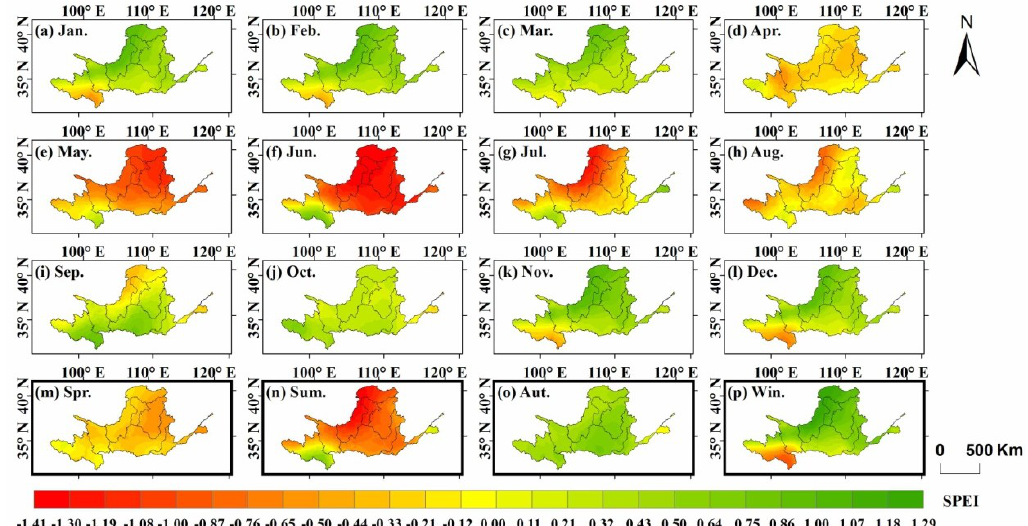
Figure 4. Spatial distribution of drought in the YRB. ( a – l ) denote monthly trends, and ( m – p ) denote seasonal trends.